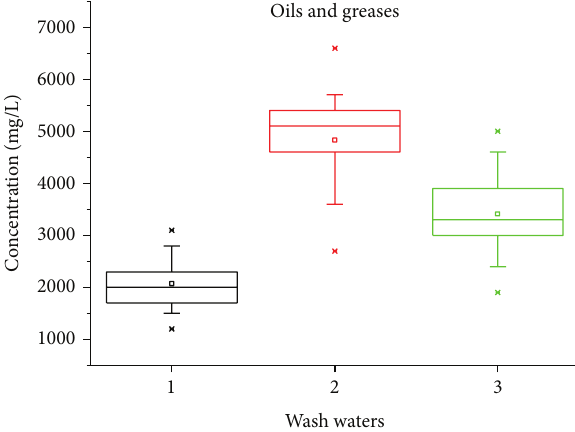
Figure 3: Box-plot variability for levels of oil and grease present in 1 a , 2 a , and 3 a wastewaters from biodiesel.